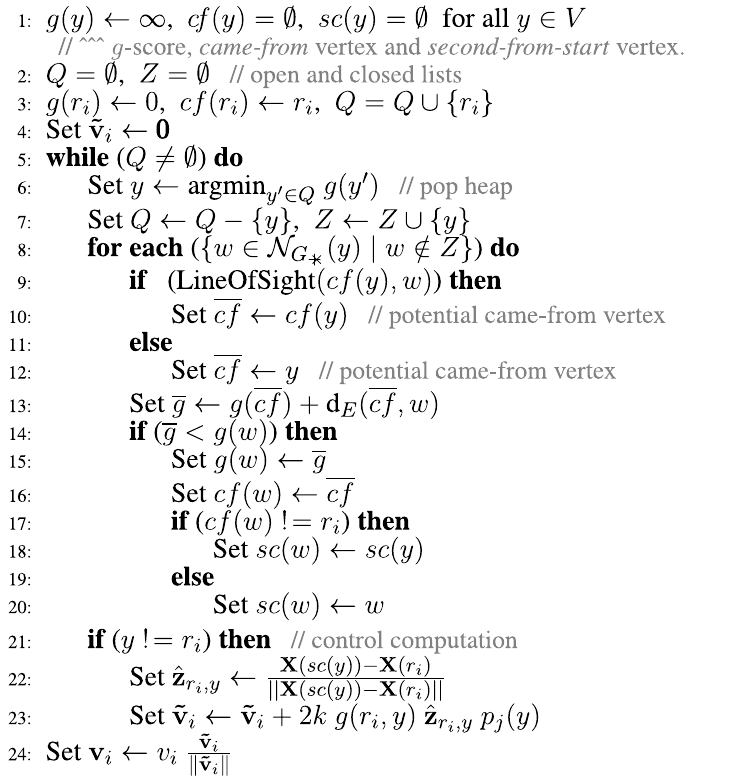
Algorithm 1 | Theta* Based Pursuer Control